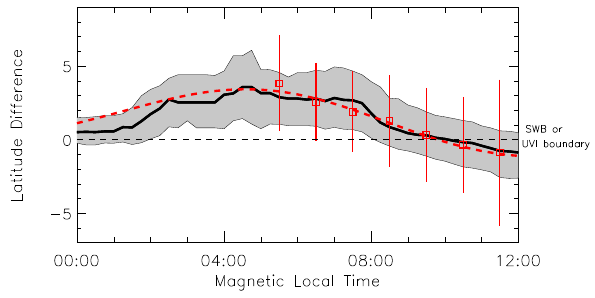
Fig. 6. The black bold line and shaded grey region represent the spa- tial variation of the median and quartile range, respectively, of the OCB-SWB latitude difference distributions as presented in Fig. 5a. The red symbols and error bars represent the spatial variation of the OCB-UVI latitude differences measured by Carbary et al. (2003). The red dashed line represents the low-order harmonic expansion fit applied to their results by Carbary et al. (2003). The dashed hor- izontal line at zero difference represents the location of the SWB or the UVI poleward